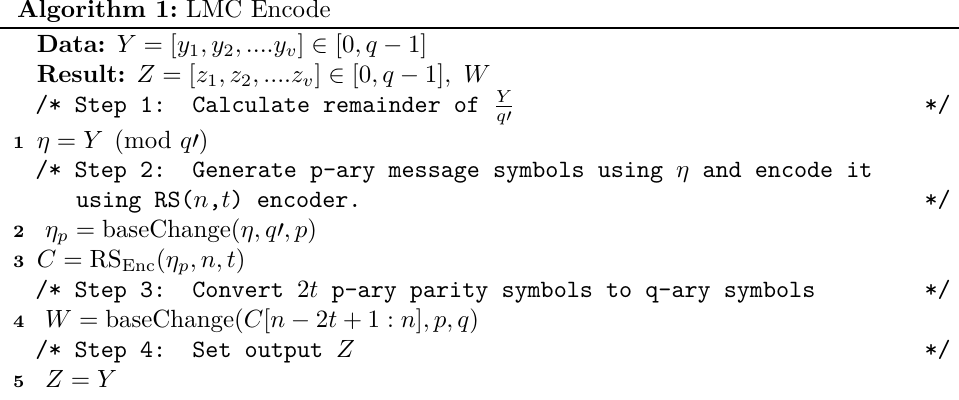
Algorithm 1: LMC